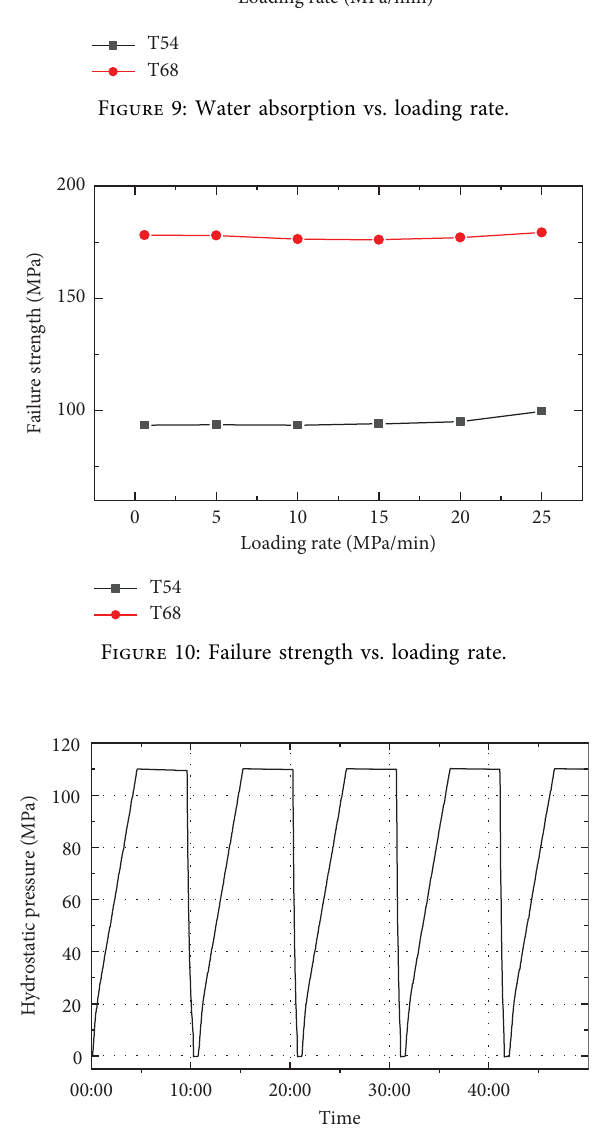
Figure 11: Cyclic loading curve (fve cycles).